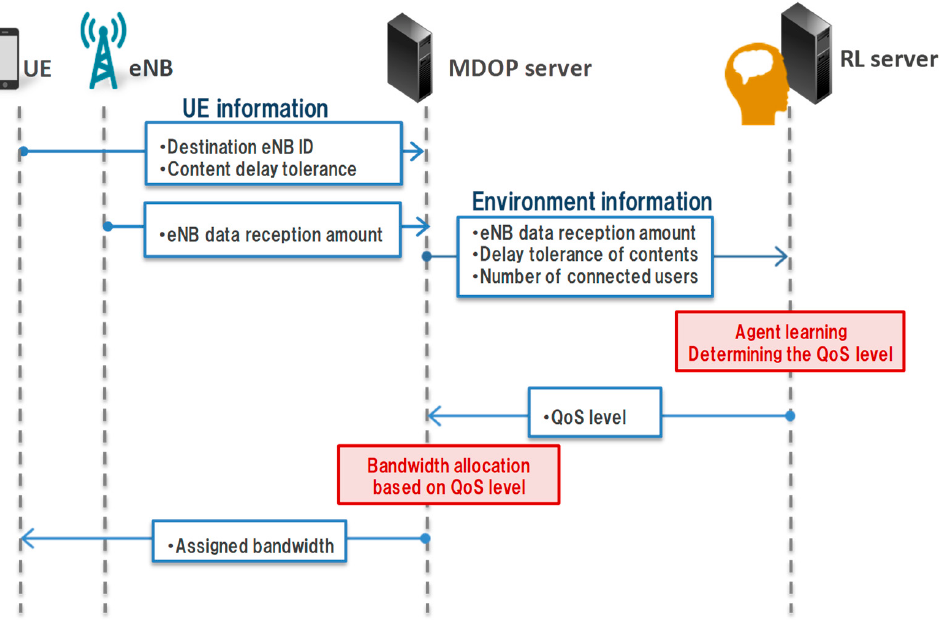
Figure 1. Learning flow of the proposed method.